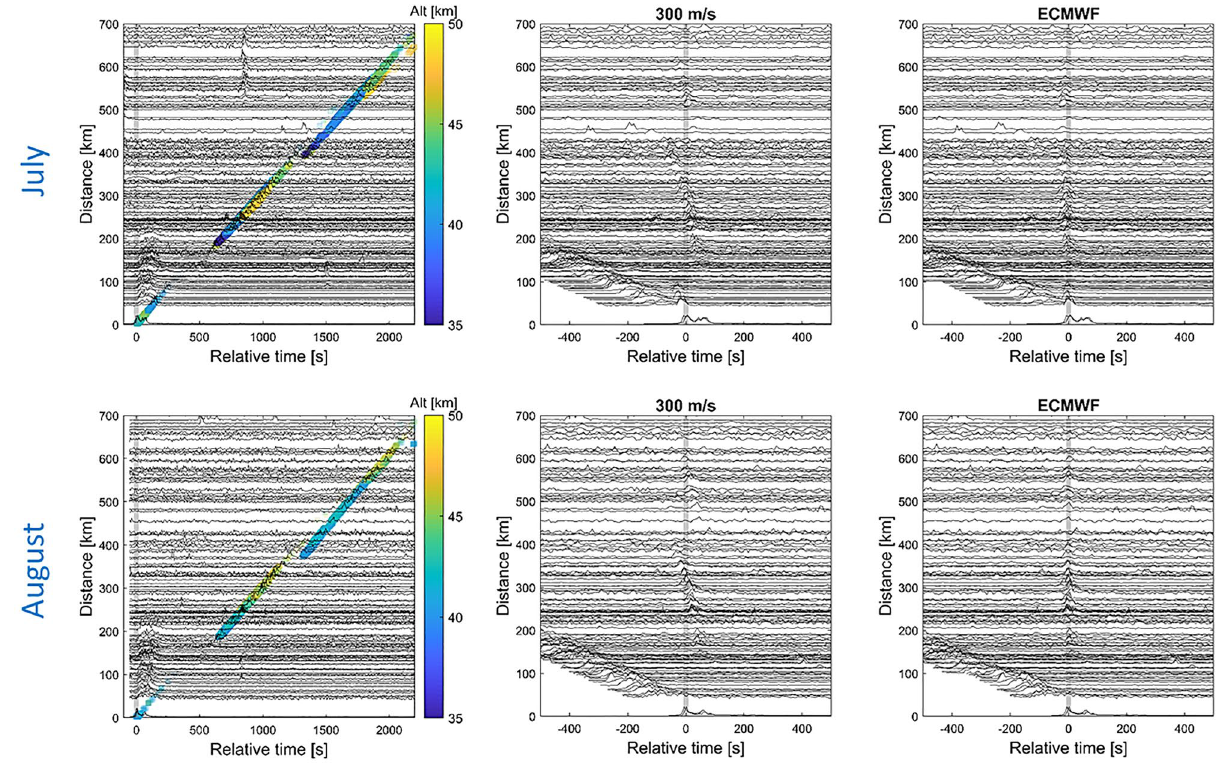
Figure 3. Hodochrons of seismic waveforms recorded at INGV seismic stations up to a distance of 700 km for the July (top, 198 stations) and August (bottom, 154 stations) eruptions. Time is relative to the main explosions (14:45:42 and 10:17:16 for the July and August eruptions, respectively). The envelopes of band-pass filtered data between 0.5 and 2 Hz are displayed. Left: distance versus relative time; theoretical arrival times derived from WASP-3D ray tracing simulations with turning heights color coded (in km). For the July eruption, the coherent seismic phases observed at a relative time of about 800 s for distances between 550 and 650 km show an apparent velocity consistent with a seismic phase. They are caused by a magnitude 1.8 earthquake that occurred at 16:59:30 UTC 33 km west of Siena, Tuscany (http:// terre moti. ingv. it/ event/ 22597 531). Middle: time shifted traces using a constant celerity model of 300 m/s. Right: time shifted traces using celerity models derived from WASP-3D shifted seismograms according to a fixed celerity and modelled propagation times for stratospheric ducting (hodochrons in Fig. 1). Records exhibiting abnormal noise level likely related to sensor malfunction have been discarded. Time is relative to the origin of the main explosion (14:45:42 and 10:17:14 for the July and August eruptions, respectively) and are calculated from local infrasound records (Fig. 2) corrected for the source-to- receiver propagation time. Aligning the envelopes of band-pass filtered data between 0.5 and 2 Hz using a con- stant celerity of 300 m/s reveals the signature of stratospherically ducted air-to-ground phases up to a propaga- tion range of ~ 600 km 34 .